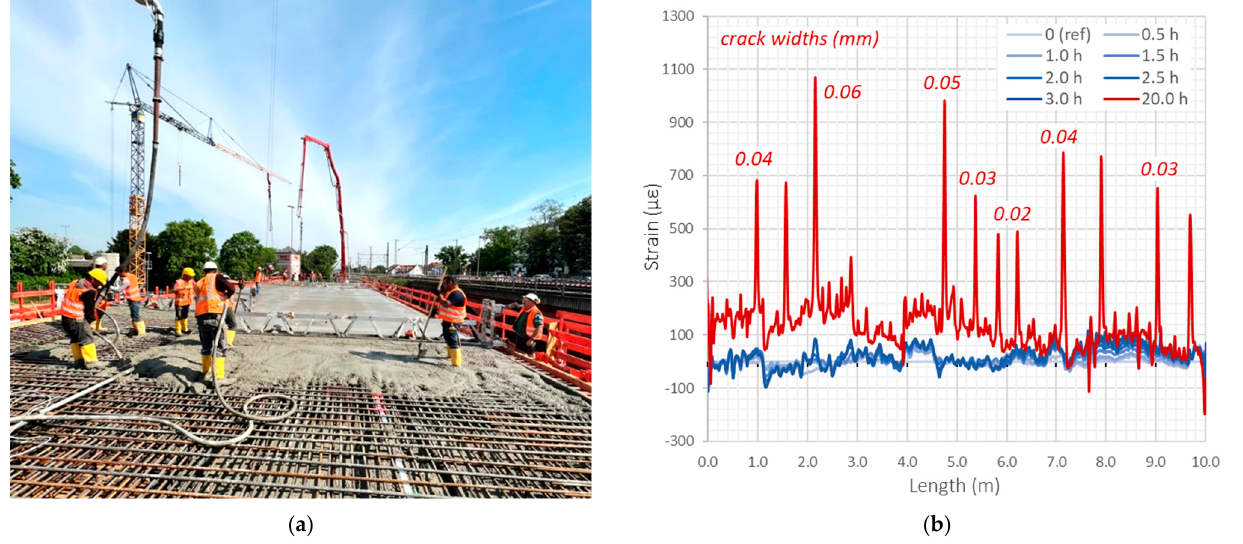
Figure 18. ( a ) The view of the slab during concreting; ( b ) example strain profiles with crack analysis 20 h after